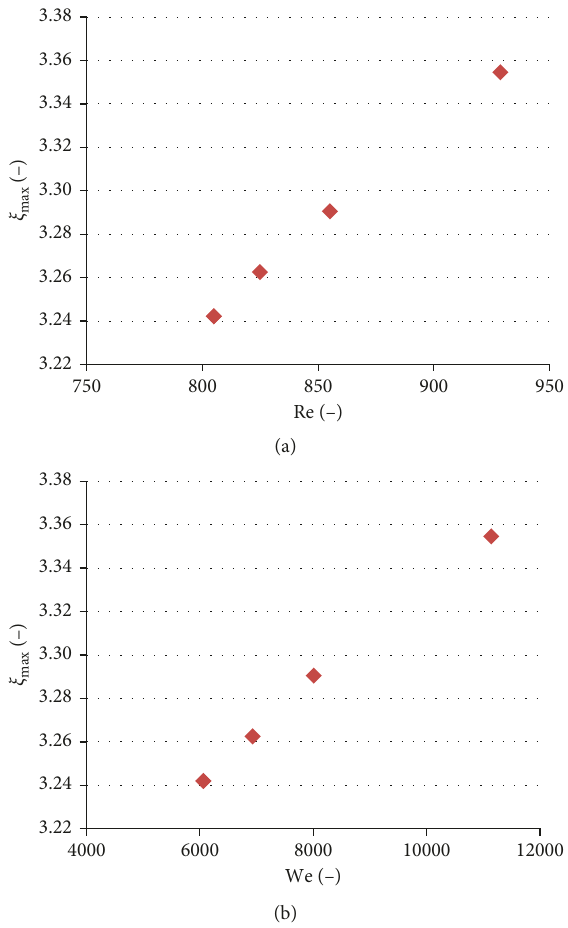
Figure 8: Diagrams presenting the relation between the maximum spreading factor and dimensionless Re and We numbers in ex- periments A–E.